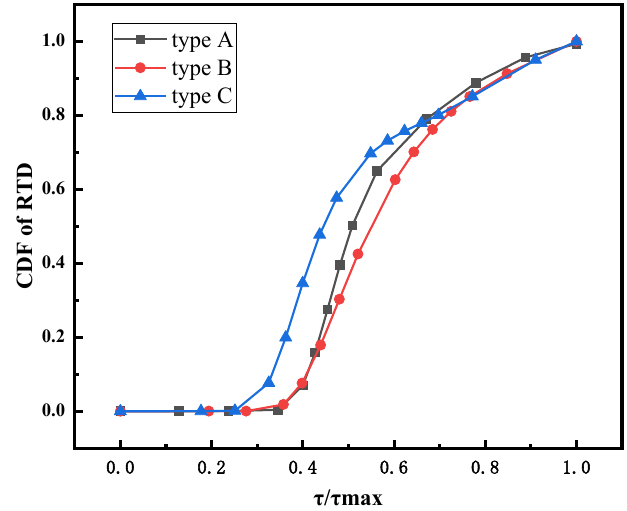
Figure 17. CDF of RTD at different feeding